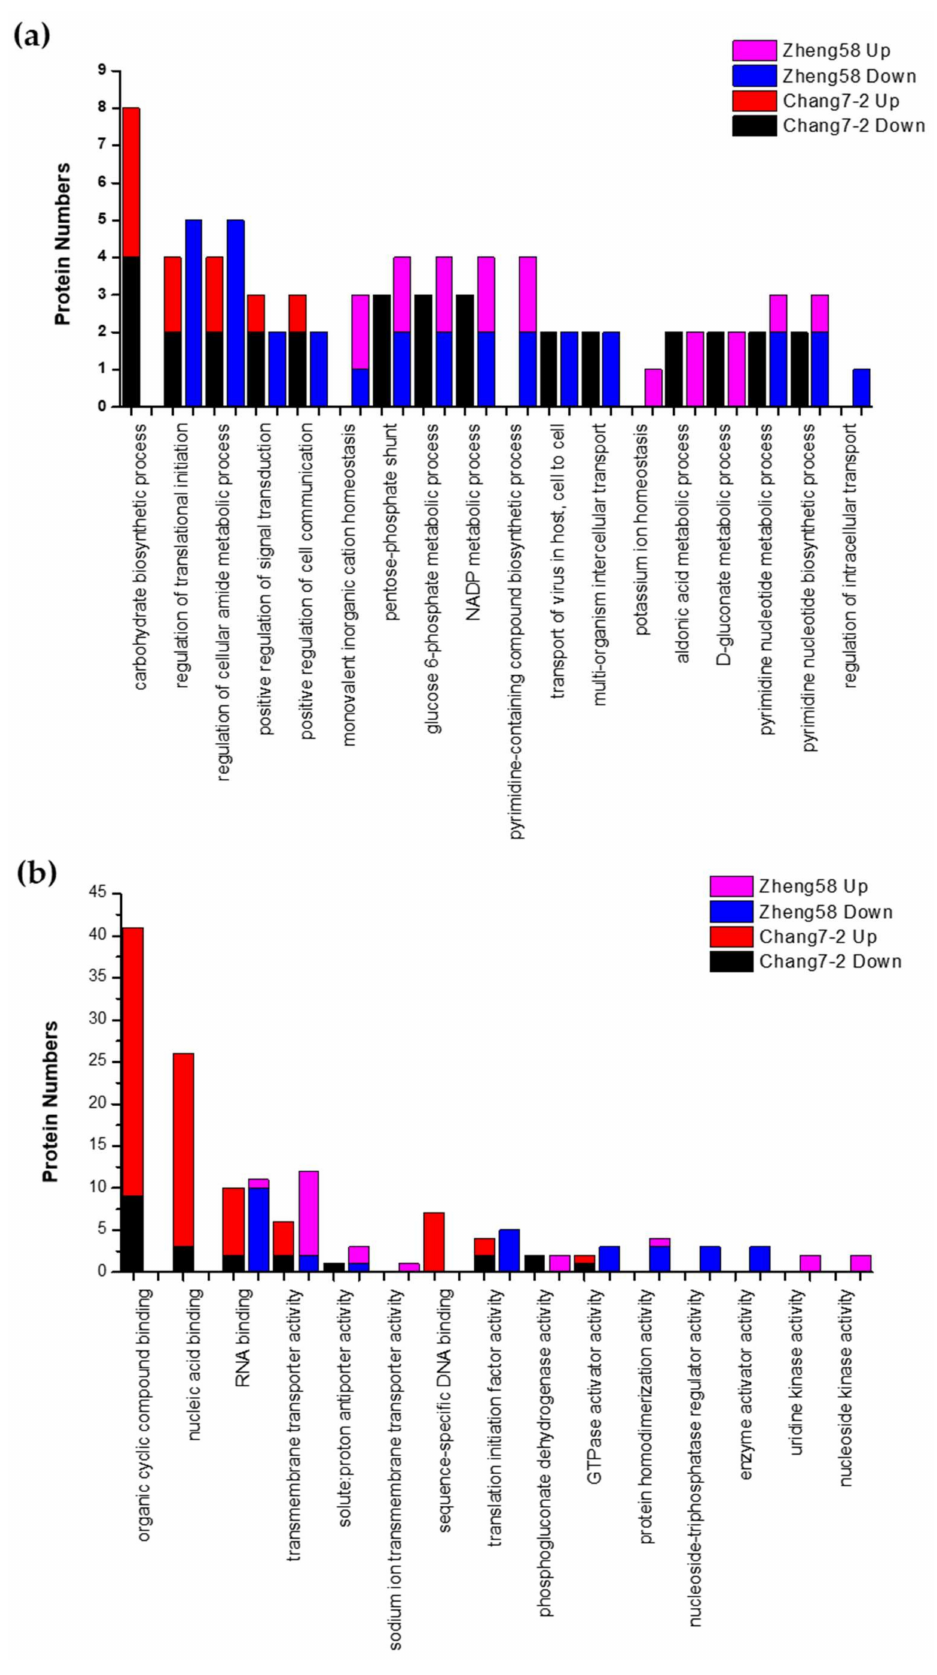
Figure 6. Gene Ontology (GO) analysis of DRPPs in roots of Chang7-2 and Zheng58. GO terms in biological processes ( a ) and molecular functions ( b ) are